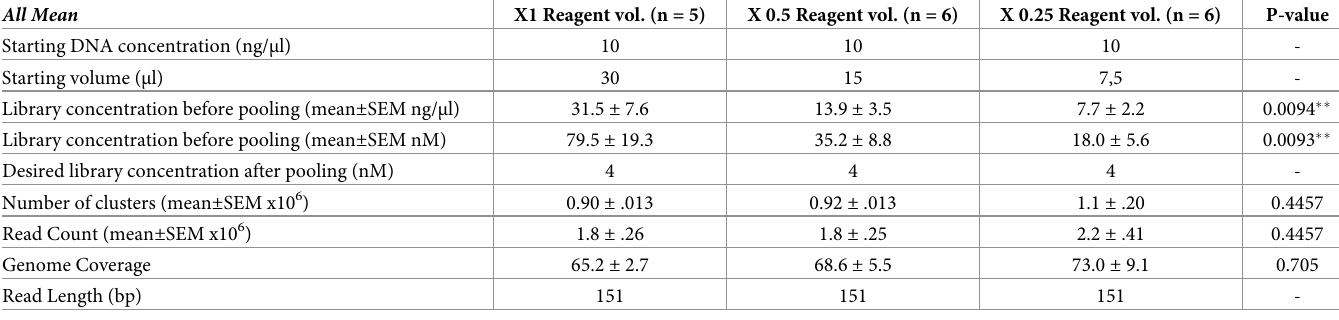
Table 3. Impact of reducing initial DNA and reagent usage during library prep on read recovery and genome coverage. All Mean X1 Reagent vol. (n = 5)